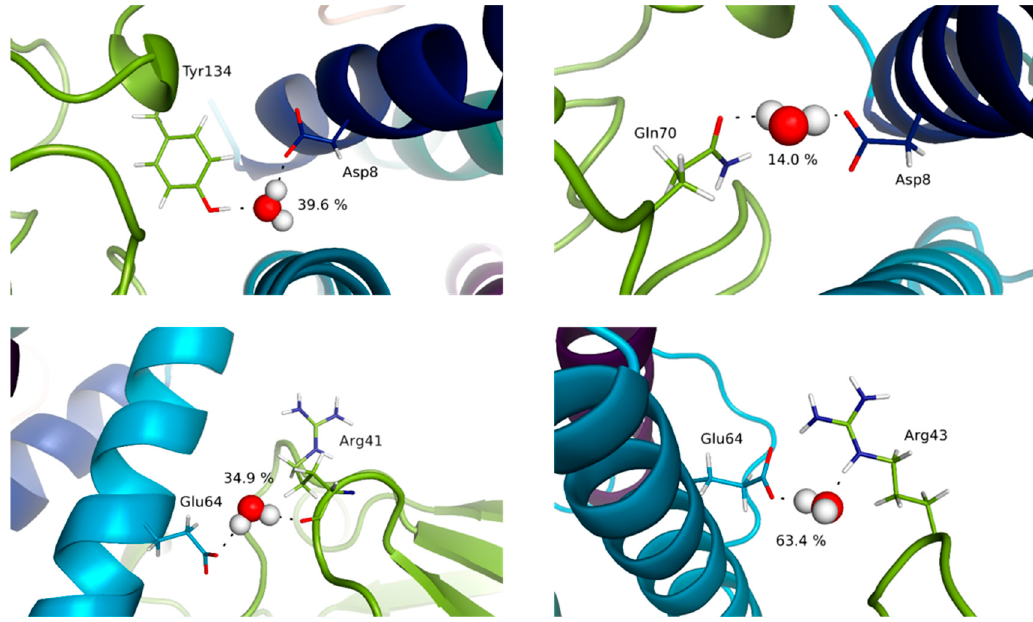
Figure 10. Representation of key bridging water molecules at the IL-15/IL-2R β interface for the full system ( left ) and the trimeric system ( right ). The values indicated correspond to the percentage of presence of the water molecules along the simulation time.